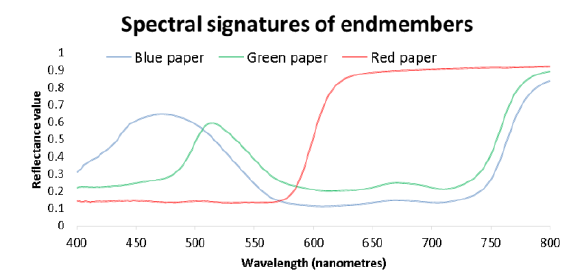
Figure 1: Spectral signatures of the cellulose papers in 400-800 nm